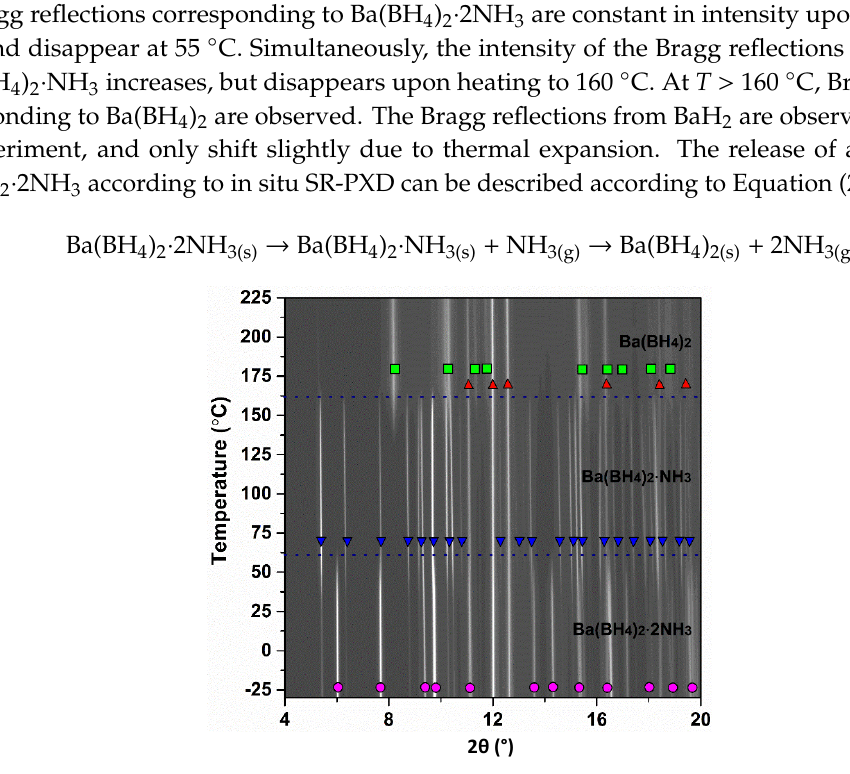
Figure 6. In situ SR-PXD for sample s2 measured from −30 to 225 °C (Δ T /Δ t = 5 °C/min, p (Ar) = 1 bar, · 2NH · NH λ = 0.7129 Å). Ba(BH 4 ) 2 ∙2NH 3 (pink circles), Ba(BH 4 ) 2 ∙NH 3 (blue triangles), Ba(BH 4 ) 2 (green squares), λ = 0.7129 Å). Ba(BH 4 ) 2 3 (pink circles), Ba(BH 4 ) 2 3 (blue triangles), Ba(BH 4 ) 2 (green squares), BaH 2 (red triangles). BaH 2 (red